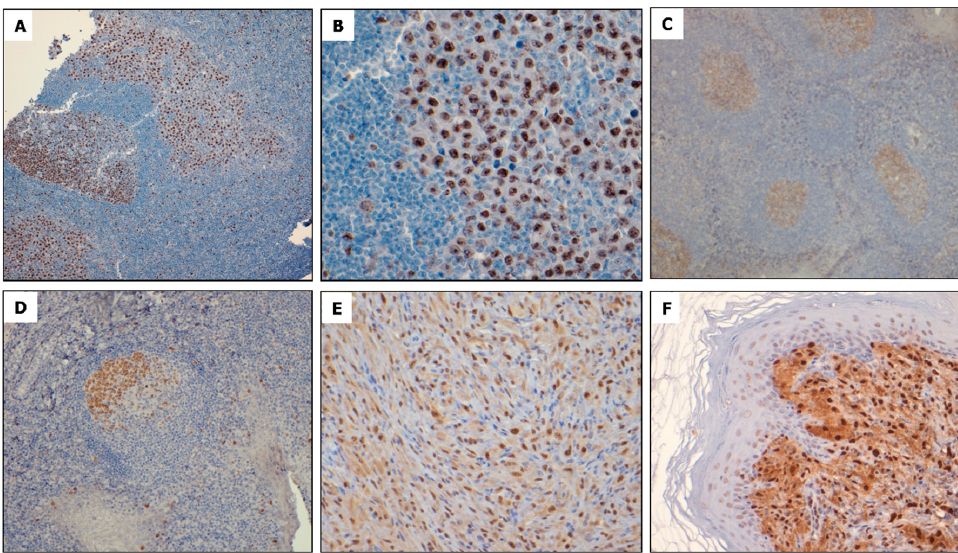
Figure 2. FOXM1 is expressed in primary tumors of patients diagnosed with ALK + ALCL and tumors developing in transgenic mice expressing NPM-ALK in lymphocytes. ( A ) Immunohistochemical staining of a representative case of ALK + ALCL shows FOXM1 expression in reactive germinal center lymphocytes and large lymphoma cells infiltrating the sinus of a lymph node (immunoperoxidase, 100×). ( B ) High magnification (400×) of the same case of ALK + ALCL highlighting strong FOXM1 staining in the nuclei of lymphoma cells. In comparison, the surrounding benign, small lymphocytes are negative for FOXM1. ( C ) Immunohistochemical studies of a reactive tonsil show that FOXM1 expression is largely restricted to germinal centers. ( D ) High magnification of the same case of tonsil revealed that FOXM1 staining was largely restricted to centroblasts in germinal centers (400×). ( E ) and ( F ) ALK + ALCL tumors arising from NPM-ALK transgenic mice express nuclear and cytoplasmic FOXM1 in the neoplastic cell population, even though FOXM1 staining is stronger in the nucleus when compared to the cytoplasm (400 ×